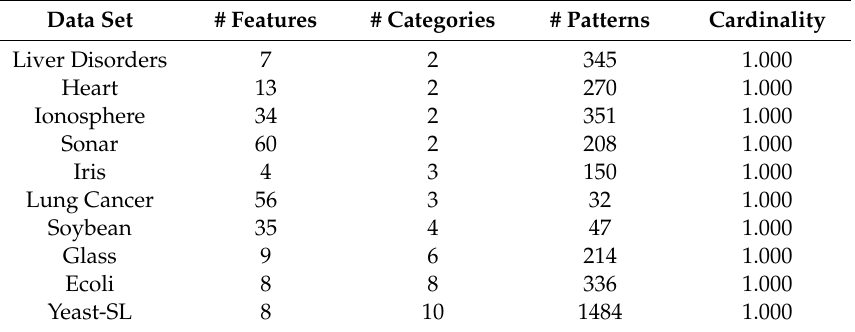
Table 1. Single-label data sets for